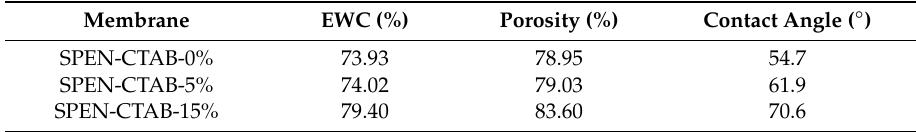
Table 1. The equilibrium water content (EWC), porosity obtained from Equation (4) and contact angle of SPEN-CTAB-0%, SPEN-CTAB-5% and SPEN-CTAB-15%.